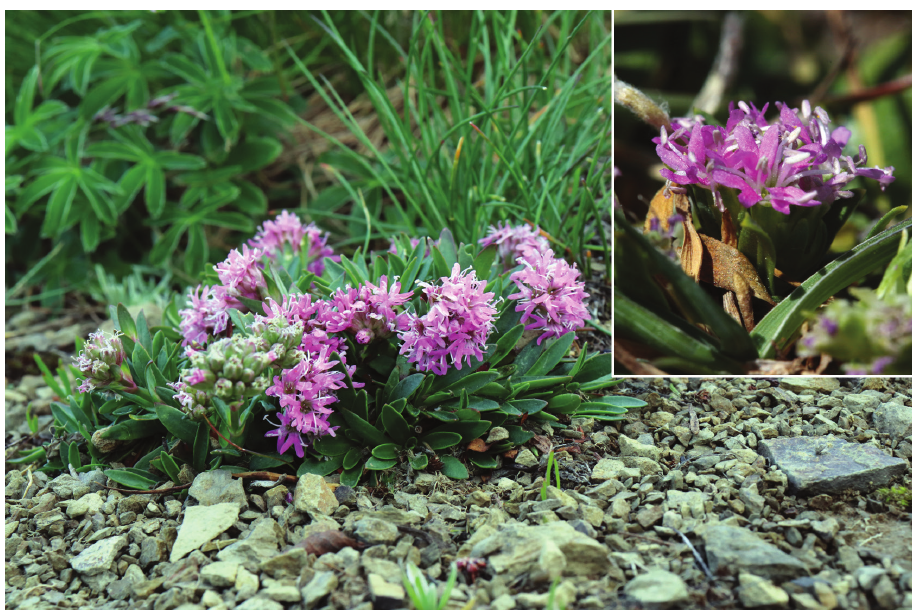
Figure 5. Viscaria alpina at Mount Prado, Northern Apennines, Italy. Photograph by Thomas